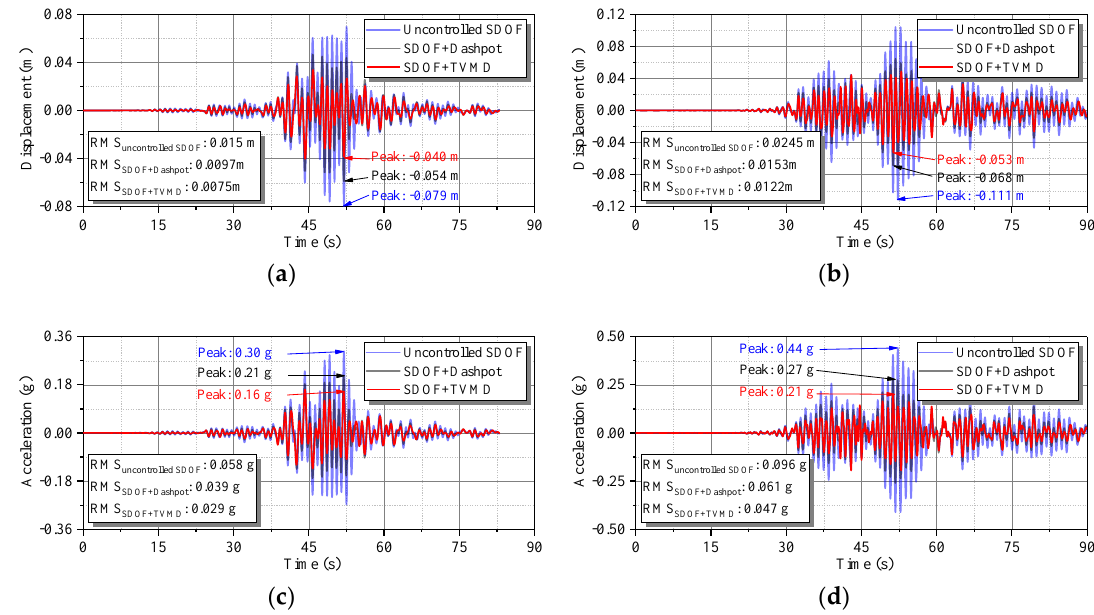
Figure 18. Displacement and acceleration response results of designed SDOF elements. ( a ) Displacement under excitation of TAP077. ( b ) Displacement under excitation of CHY102. ( c ) Acceleration under excitation of TAP077. ( d ) Acceleration under excitation of CHY102.